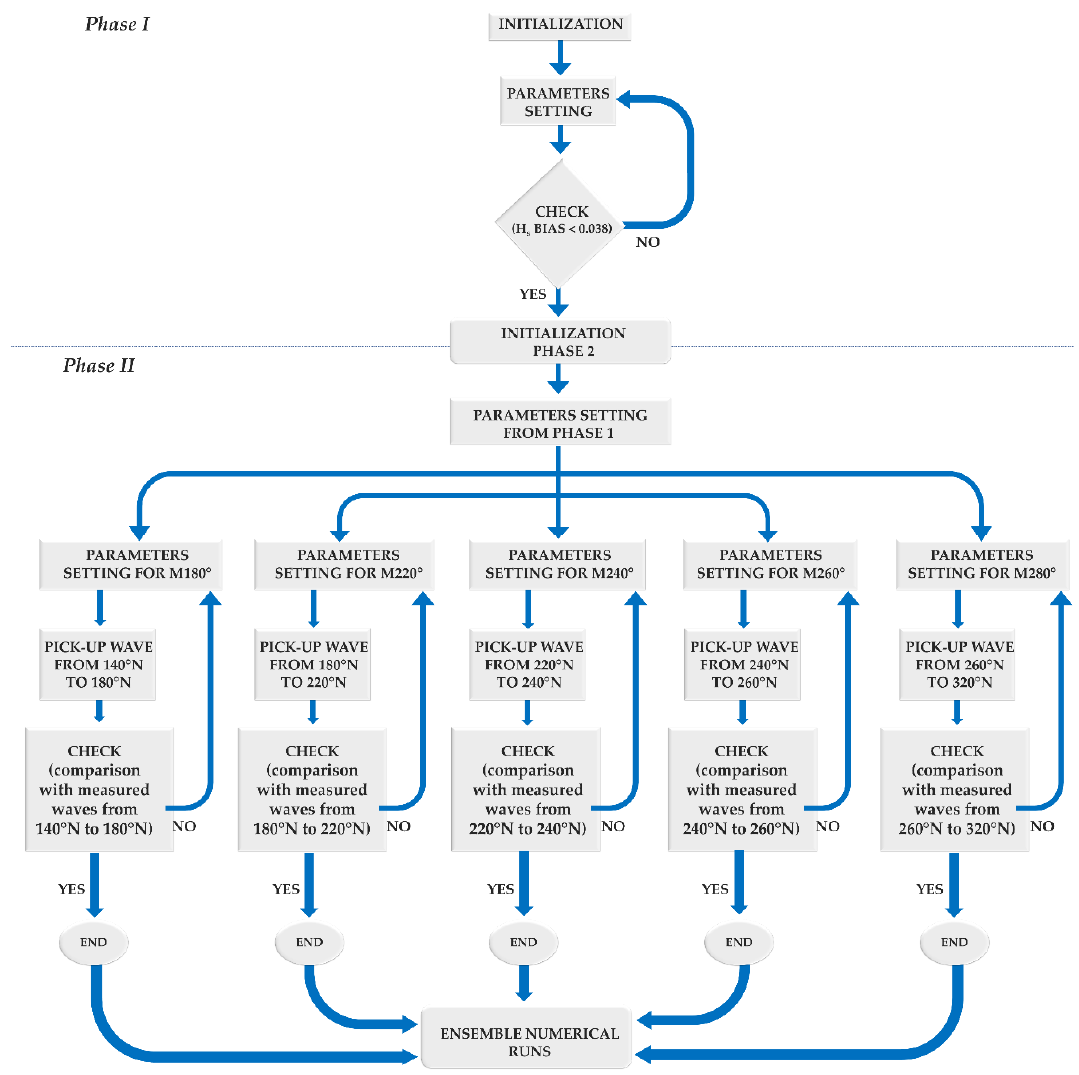
Figure 10. Flow chart of the two-phase calibration procedure.